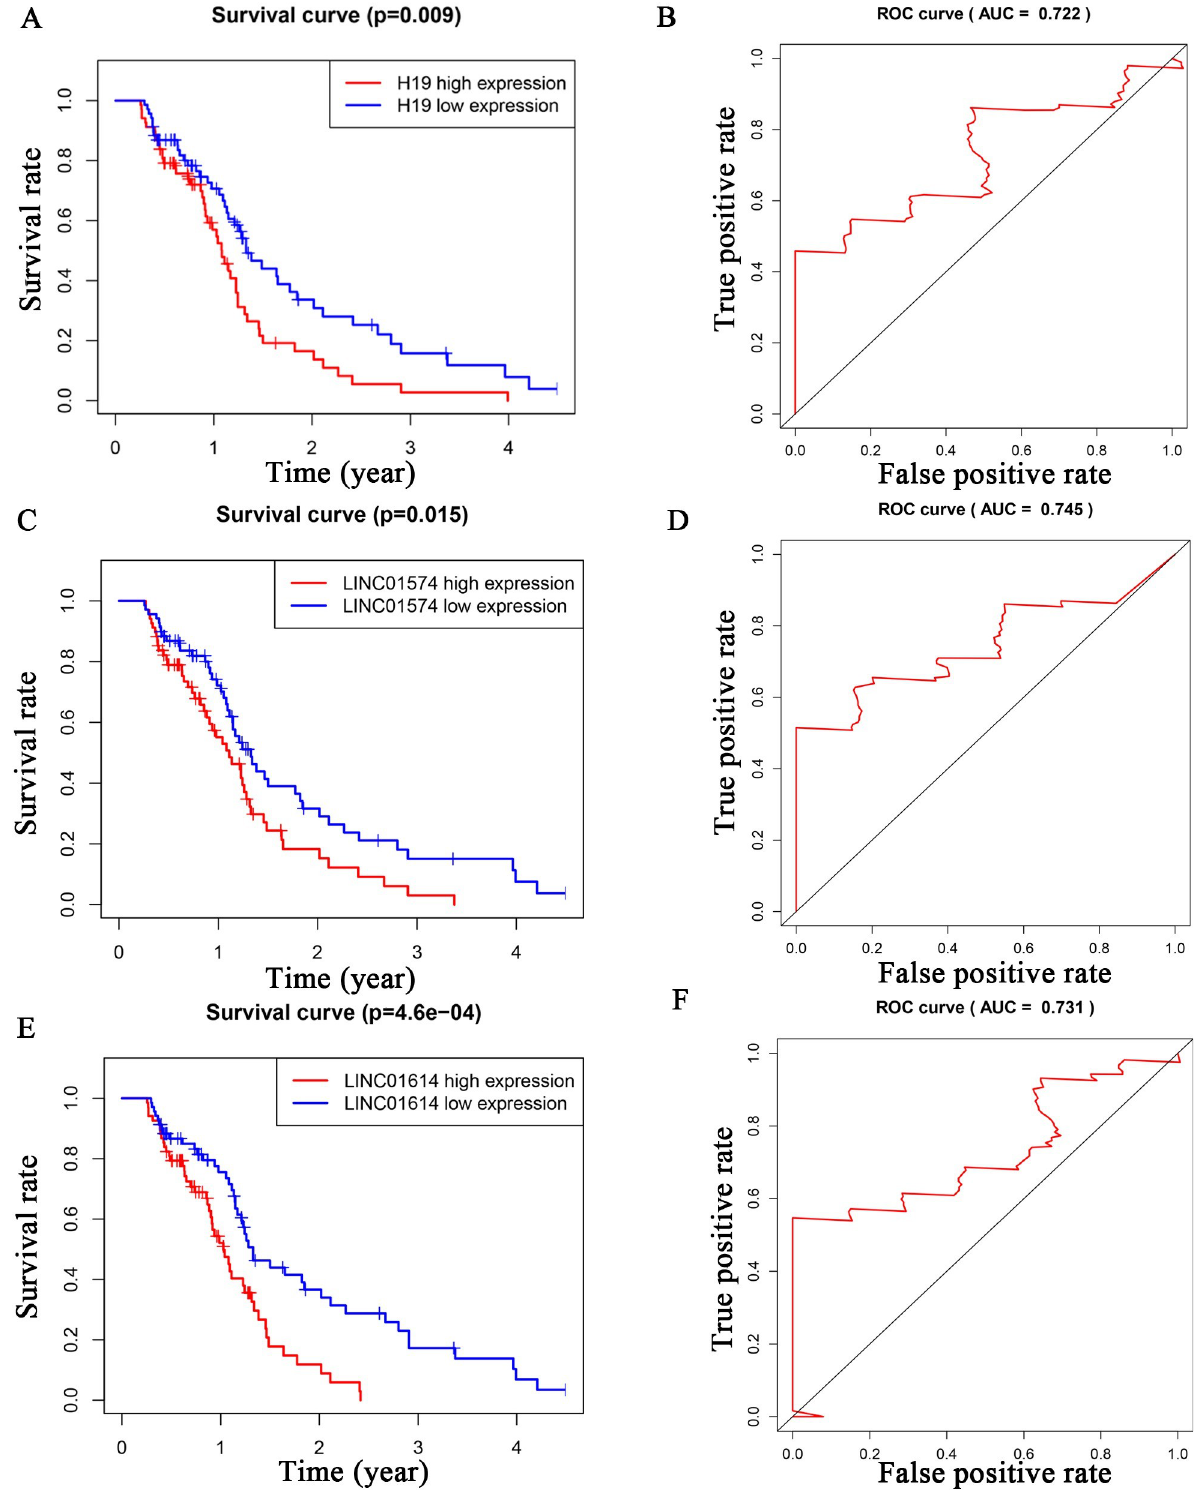
Fig 3. Kaplan–Meyer and ROC analyses of survival-related lncRNAs (H19, LINC01574, LINC01614). We examined the differentially expressed lncRNAs by Kaplan–Meyer and ROC analyses. The lncRNAs with p-values < 0.05 and ROC values > 0.7 were H19 (Fig 3A and 3B), LINC01574 (Fig 3C and 3D), LINC01614 (Fig 3E and